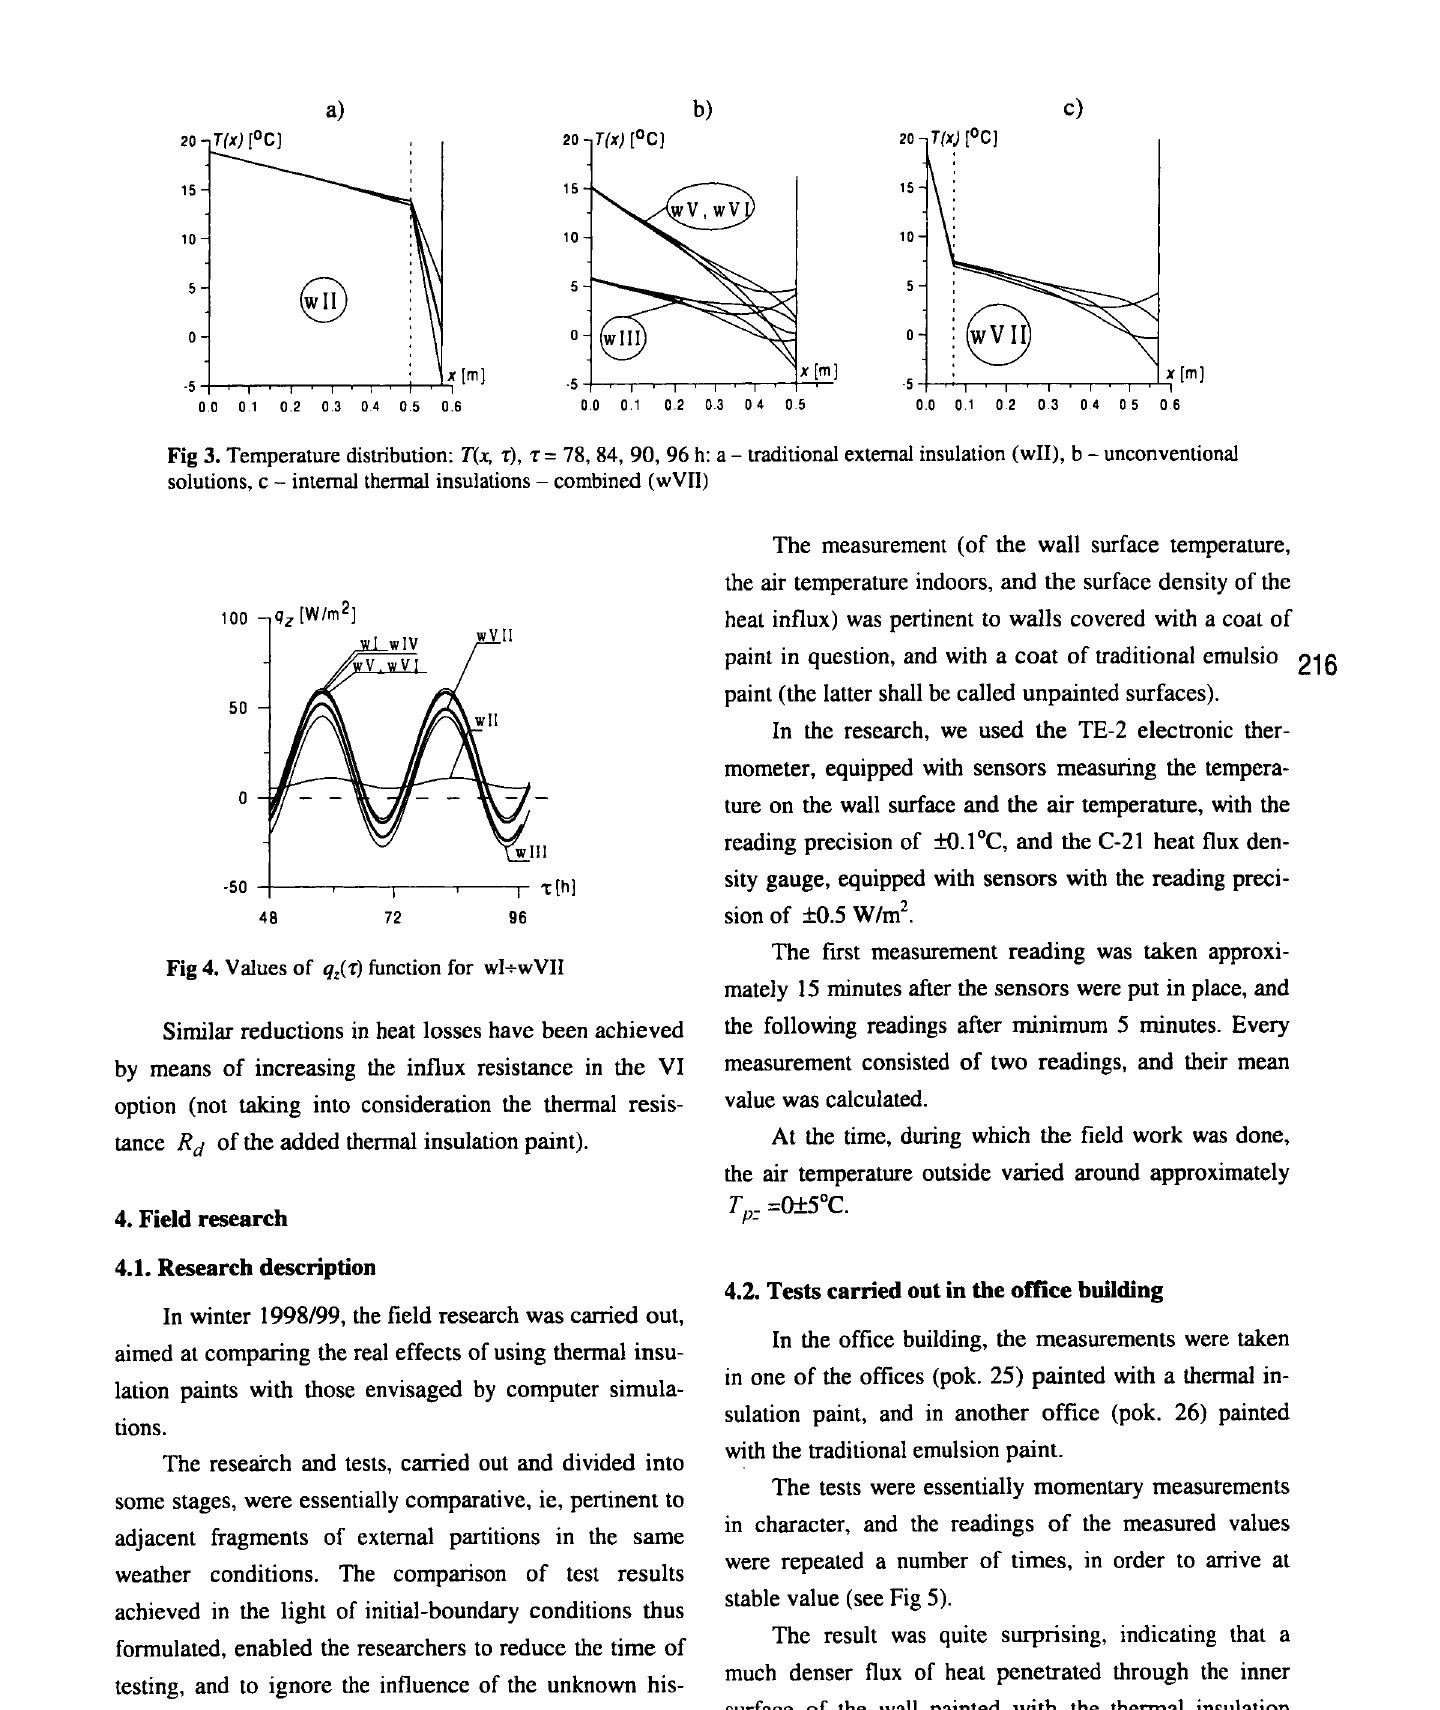
Fig 4. Values of qz(T) function for